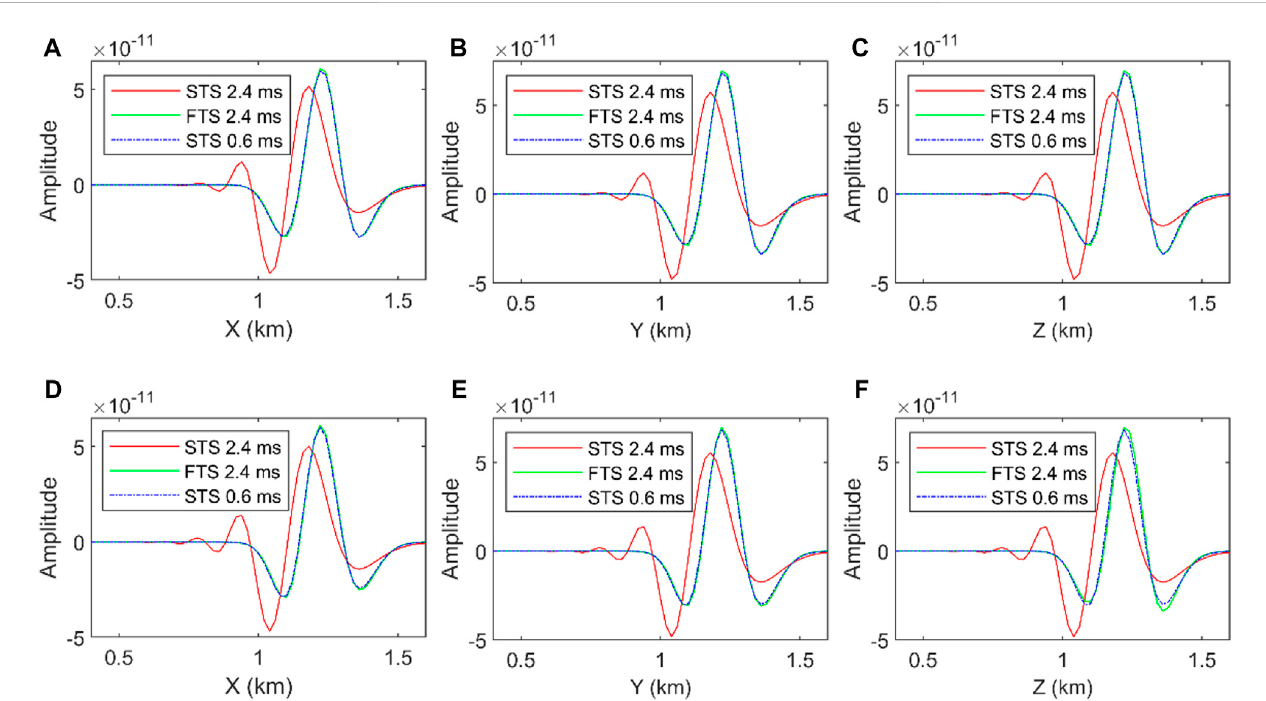
FIGURE 4 Pro fi lecomparisonsatthepositionsof (A) and (D) ( y , z )=(1,1)km, (B) and (E) ( x , z )=(1,1)km,and (C) and (F) ( x , y )=(1,1)km. (A - C) aretheresultsfromthe STS and FTS methods using the fourth-order accuracy in space, and (D-f) are the results from the STS and FTS methods using the sixth-order accuracy in